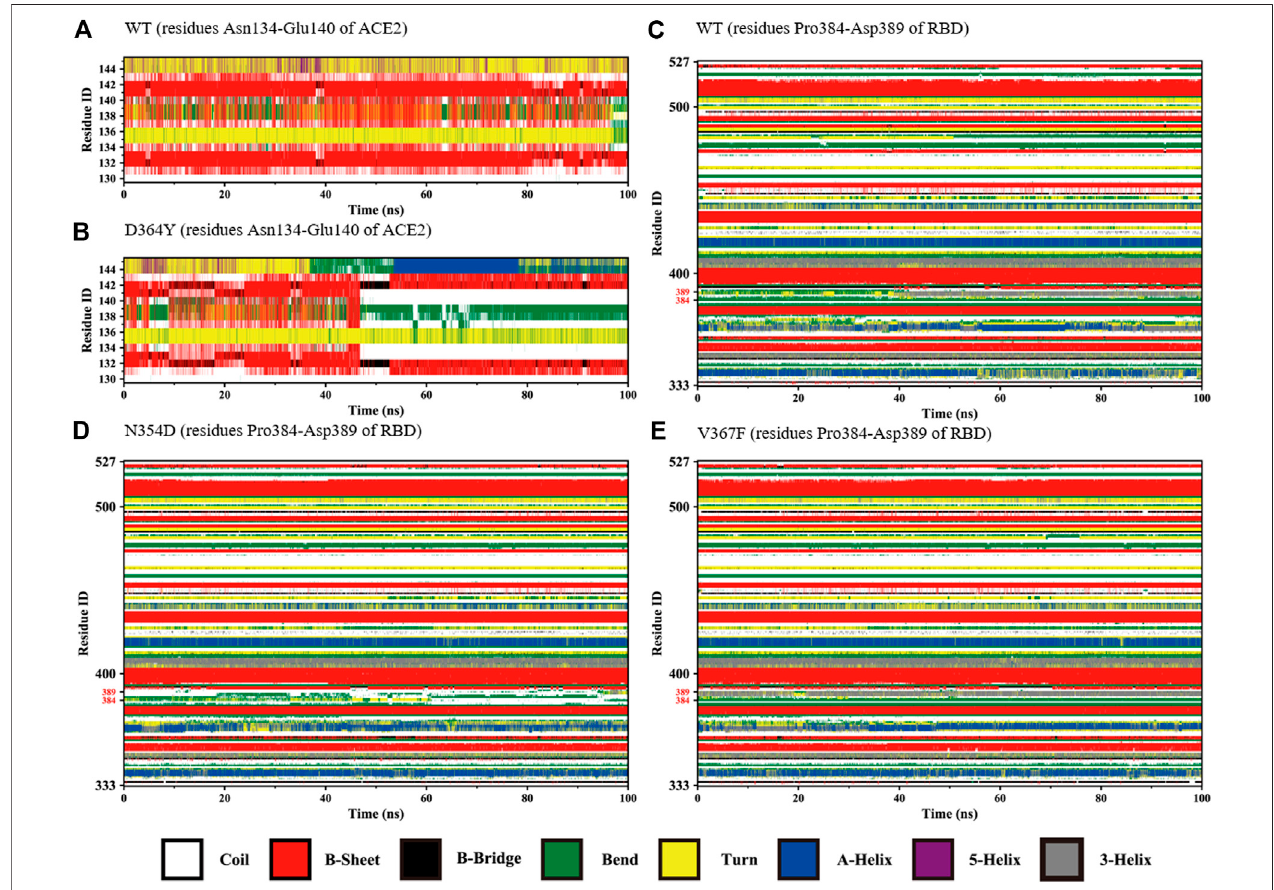
FIGURE 4 | Secondary structures of the regions (residues Asn134-Glu140 of ACE2 and Pro384-Asp389 of RBD) during the simulation. (A) Residues Asn134- Glu140 of ACE2 in the WT system. (B) Residues Asn134-Glu140 of ACE2 in the D364Y system. (C) Residues Pro384-Asp389 of RBD in the WT system. (D) Residues Pro384-Asp389 of RBD in the N354D system. (E) Residues Pro384-Asp389 of RBD in the V367F system.